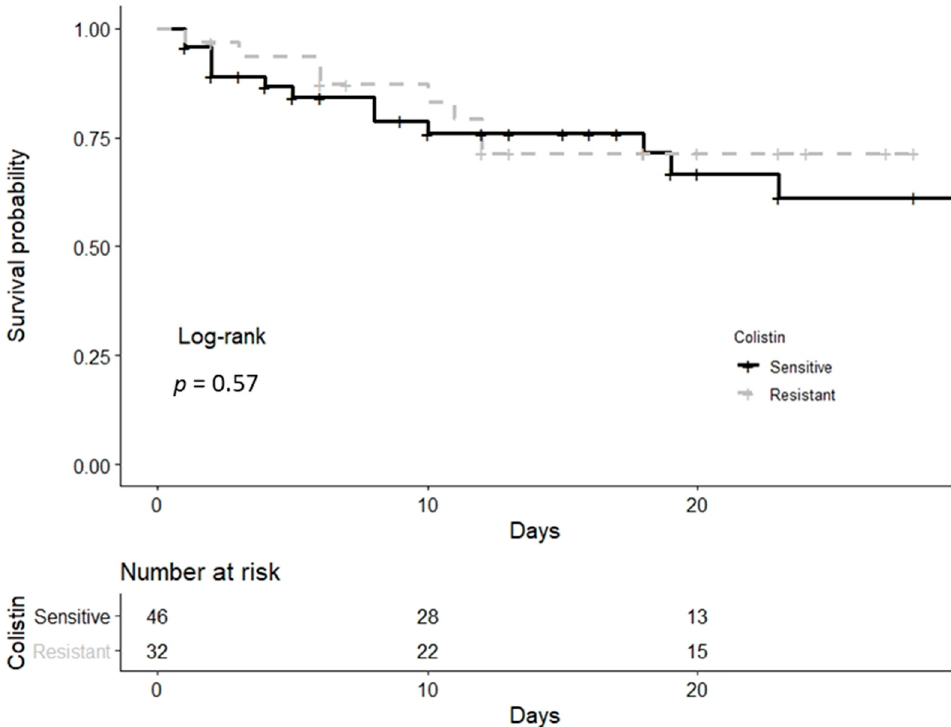
Figure 2. Kaplan–Meier survival curve of both colistin-resistant and colistin-sensitive groups until day 28 post-event. Table 3. Factors associated with 28-day mortality.